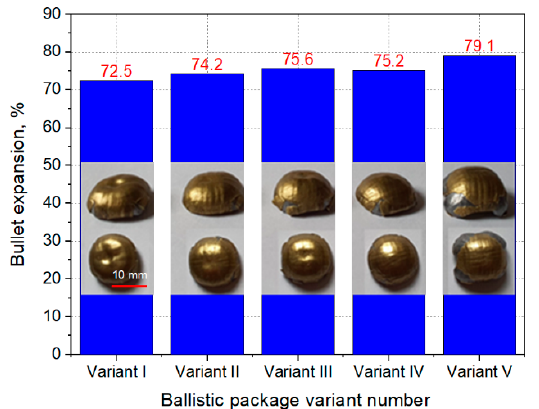
Figure 10. The expansion and view of the bullets after impact for individual variants of ballistic packages.